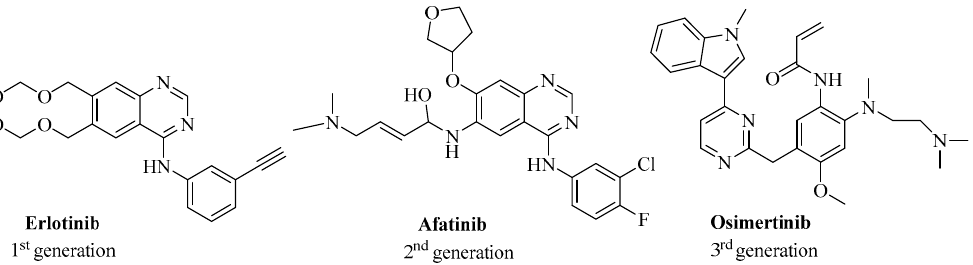
Figure 1. Two-dimensional (2D) structure of three reference drugs targeting EGFR, including erlotinib, afatinib, and osimertinib.